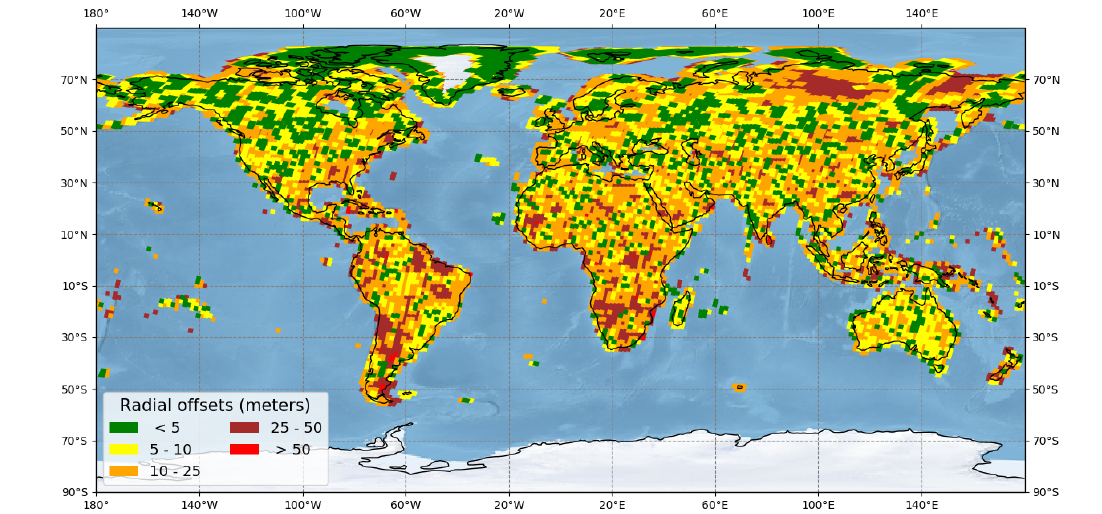
Figure 8. Radial geodetic offsets of the Landsat 8 (L8) scenes processed using the Collection-1 GCPs.